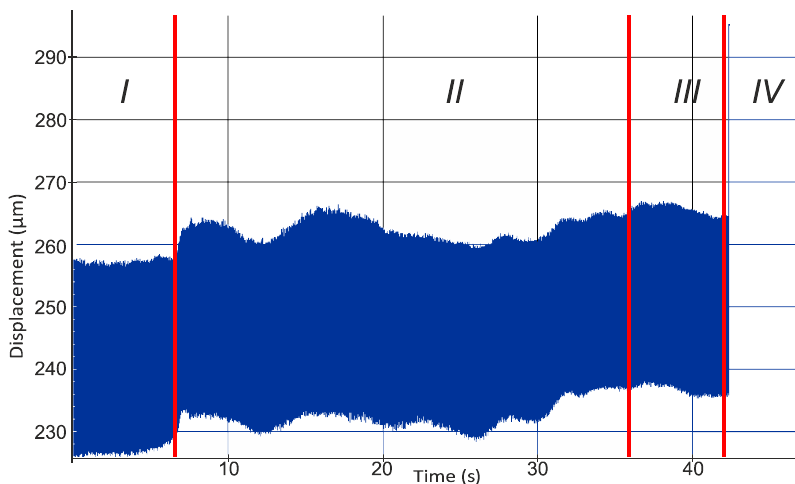
Figure 3. Displacement diagram of the tool relative to the workpiece from the sensor mounted in the direction of the x -axis for the machining conditions: v c = 360 m/min; f = 0.03 mm/rev; a p = 0.35 mm; r n = 48.6 µ m; n = 2460 rpm.